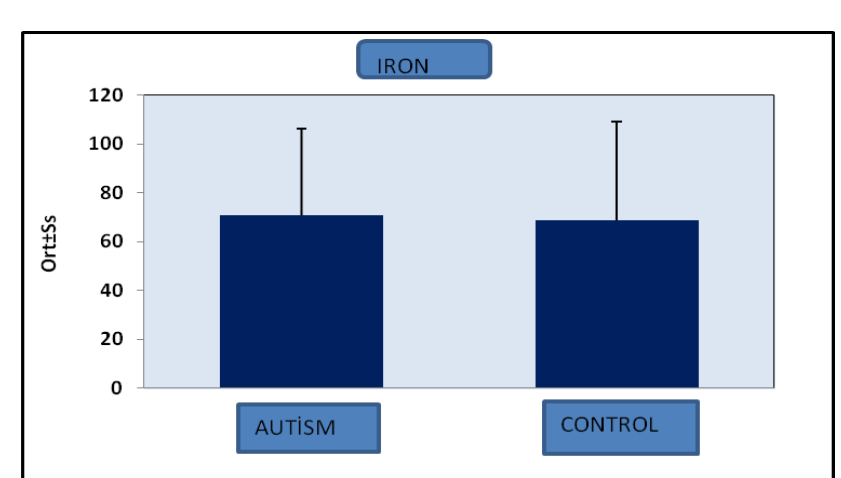
Figure 4. Distribution of Iron Measurements by Groups